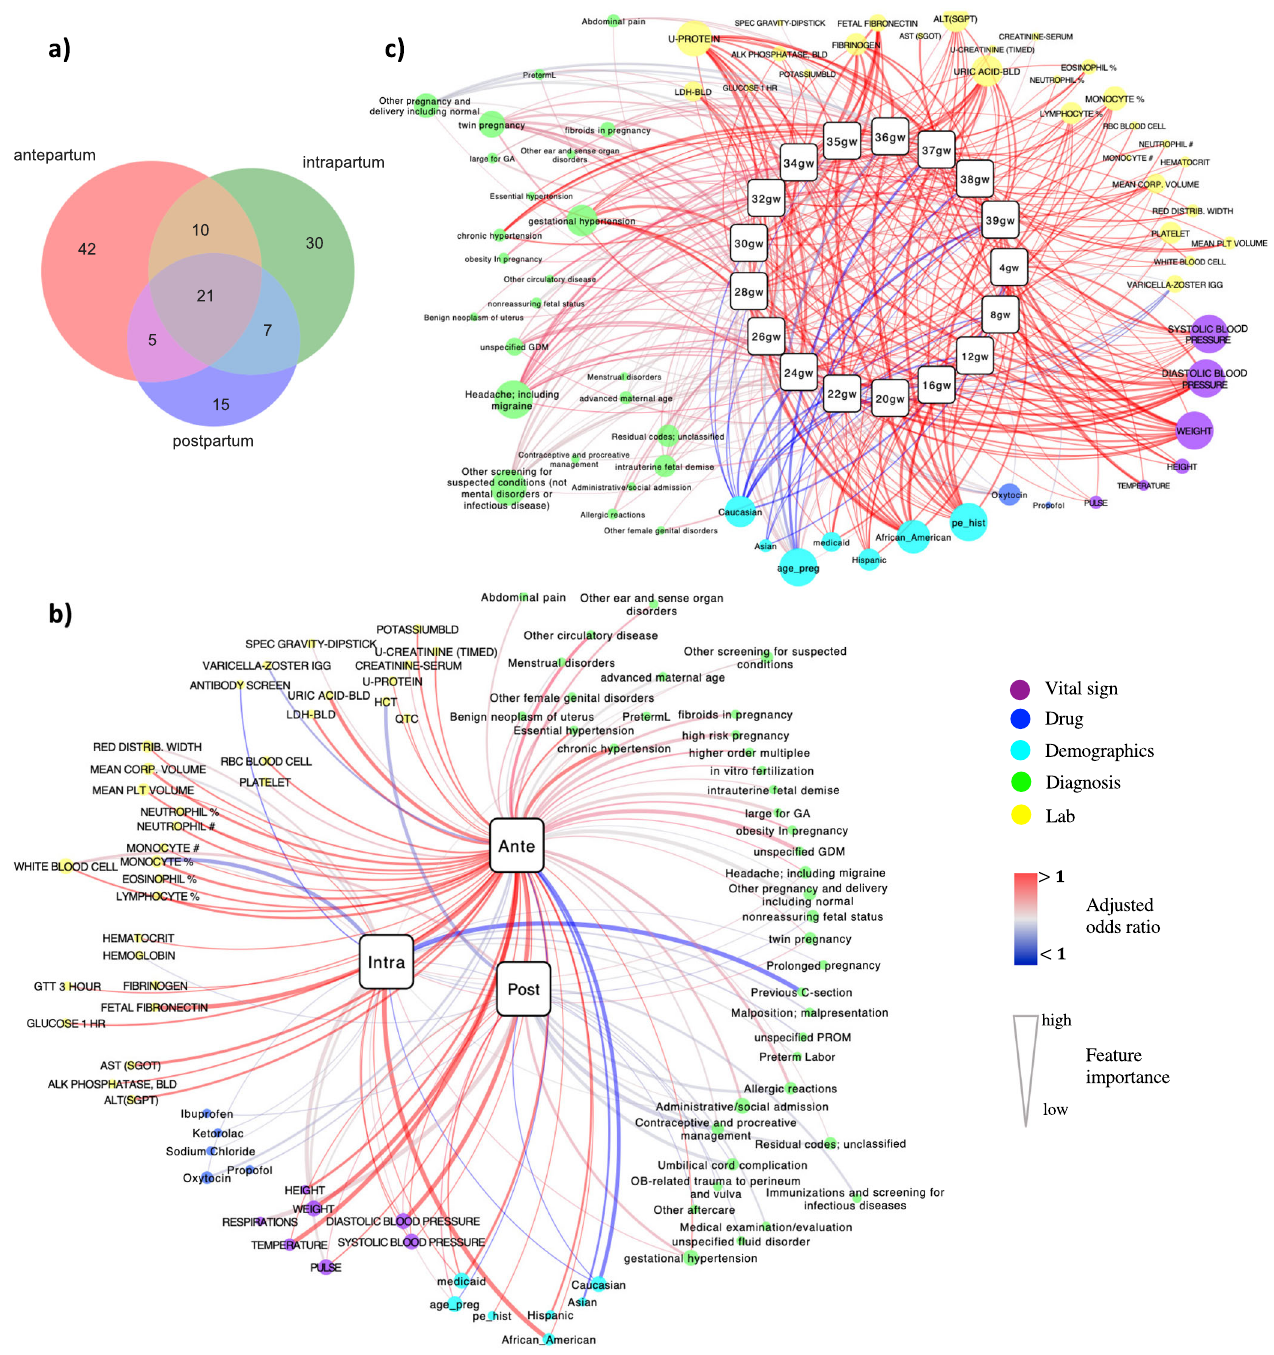
Fig. 3 Networks of feature associations through pregnancy. a Venn diagram to show common features shared with three pregnancy periods, and speci fi c features to each period. b The network to display the associations of selected clinical features with each pregnancy period. c The network for the 17 time points in the antepartum. The two networks were constructed by connecting predictive features with respective PE time point. The squares signify different time points of PE, and the round nodes represent the identi fi ed predictive features with their sizes proportional to the feature importance. The red edges indicate risk associations (adjusted OR > 1) while the blue edges indicate protective associations (adjusted OR < 1). The edge width re fl ects the signi fi cance of predictive features. Different feature categories are represented with different colors and also laid out together. The networks were visualized using Cytoscape